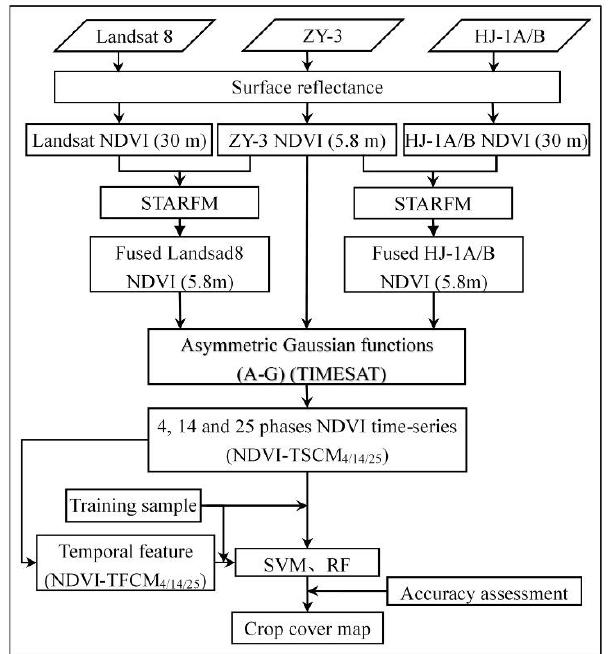
Figure 2. The flowchart of crop classification based on the spatial and temporal adaptive reflectance fusion model